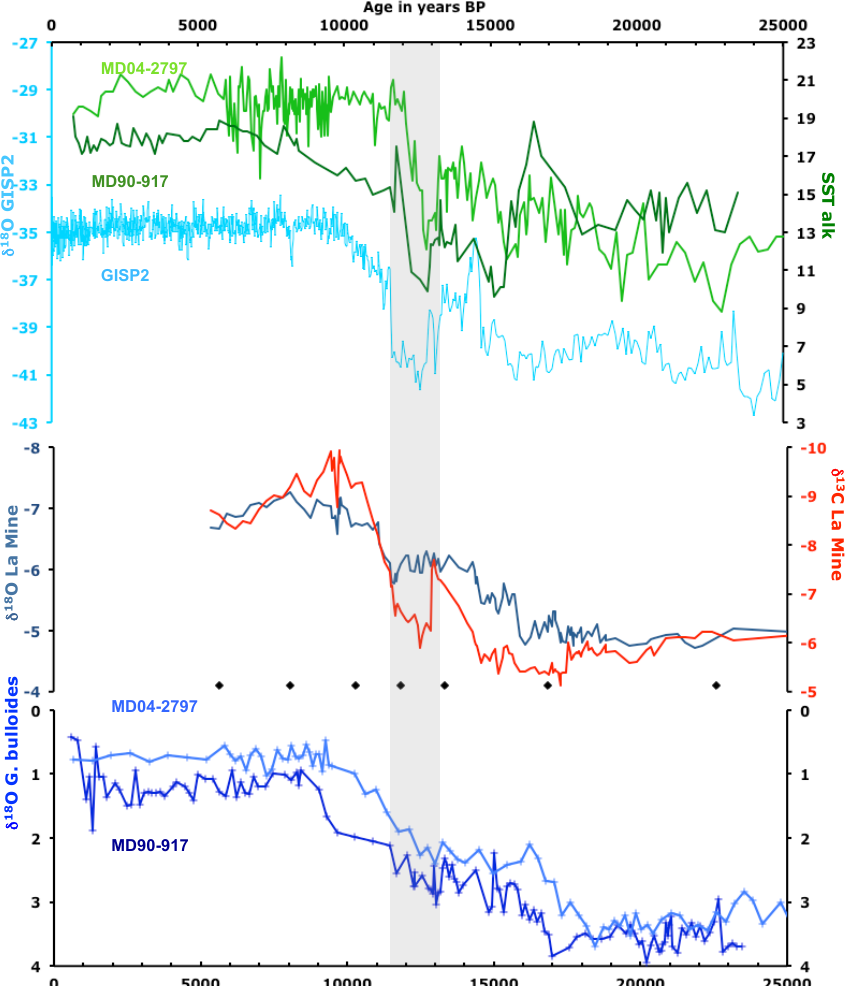
Fig. 3. Comparison between SST alk in the South Adriatic Sea (this study) and Siculo–Tunisian Strait (this study and Essallami et al., 2007) cores with the δ 18 O in the Greenland ice core GISP2, the O and C isotopes in La Mine stalagmite (Tunisia) (this study and Genty et al., 2006) and the δ 18 O in G. bulloides calcite from in the South Adriatic Sea (Siani et al., 2004, 2010) and Siculo–Tunisian Strait (Essallami et al., 2007) cores. Black diamons indicate U/Th dates performed on La Mine